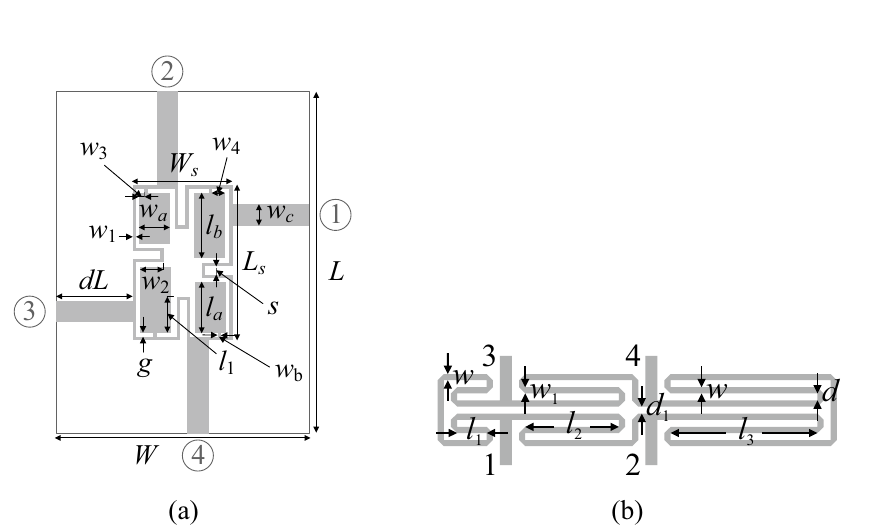
Figure 9. Microstrip structures employed as test cases for verification of the proposed size reduction framework: ( a ) compact branch-line coupler (Circuit I) 98 , ( b ) rat-race coupler with folded transmission lines (Circuit II) 99